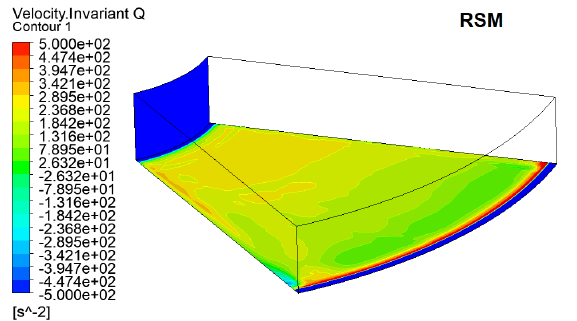
Fig. 8. Q-criterion: DES